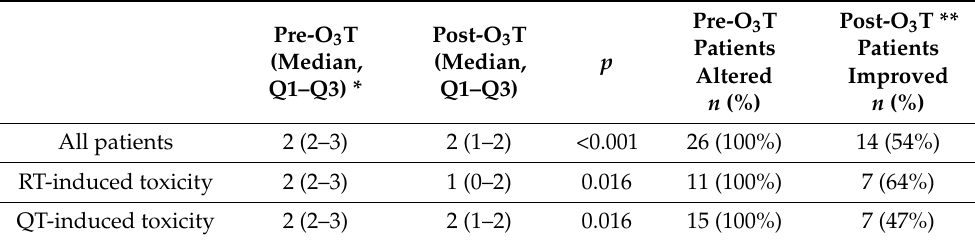
Table 3. Grade of toxicity according to the Common Terminology Criteria for Adverse Events (CTCAE) v.5.0 of the National Cancer Institute of EEUU. * Q1–Q3: quartiles 1 and 3. ** Percentage of patients with improvement regardless of initially altered patients.